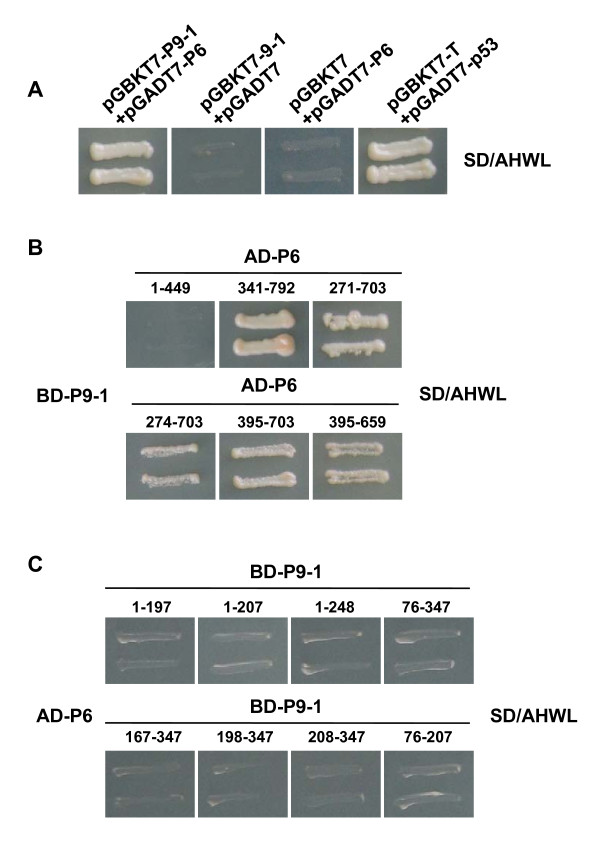
Investigation of P6-P9-1 interaction in YTH system. (A) Yeast colonies containing pGBKT7-P9-1/pGADT7-P6 grew well on the selective medium, whereas the yeast transformed with pGBKT7-P9-1 and pGADT7, used as a negative control, was unable to grow. (B) Yeast colonies expressing BD-P9-1 with AD-P6341-792, AD-P6274-703, AD-P6271-703, AD-P6395-703, or AD-P6395-659 grew well on the selective medium, but those expressing BD-P9-1 with AD-P61-449 did not. The numbers denote P6 amino acid positions. (C) Yeast colonies expressing AD-P6 with any of the P9-1 mutants fused with BD domain showed no growth on the selective medium. The numbers denote P9-1 amino acid positions.